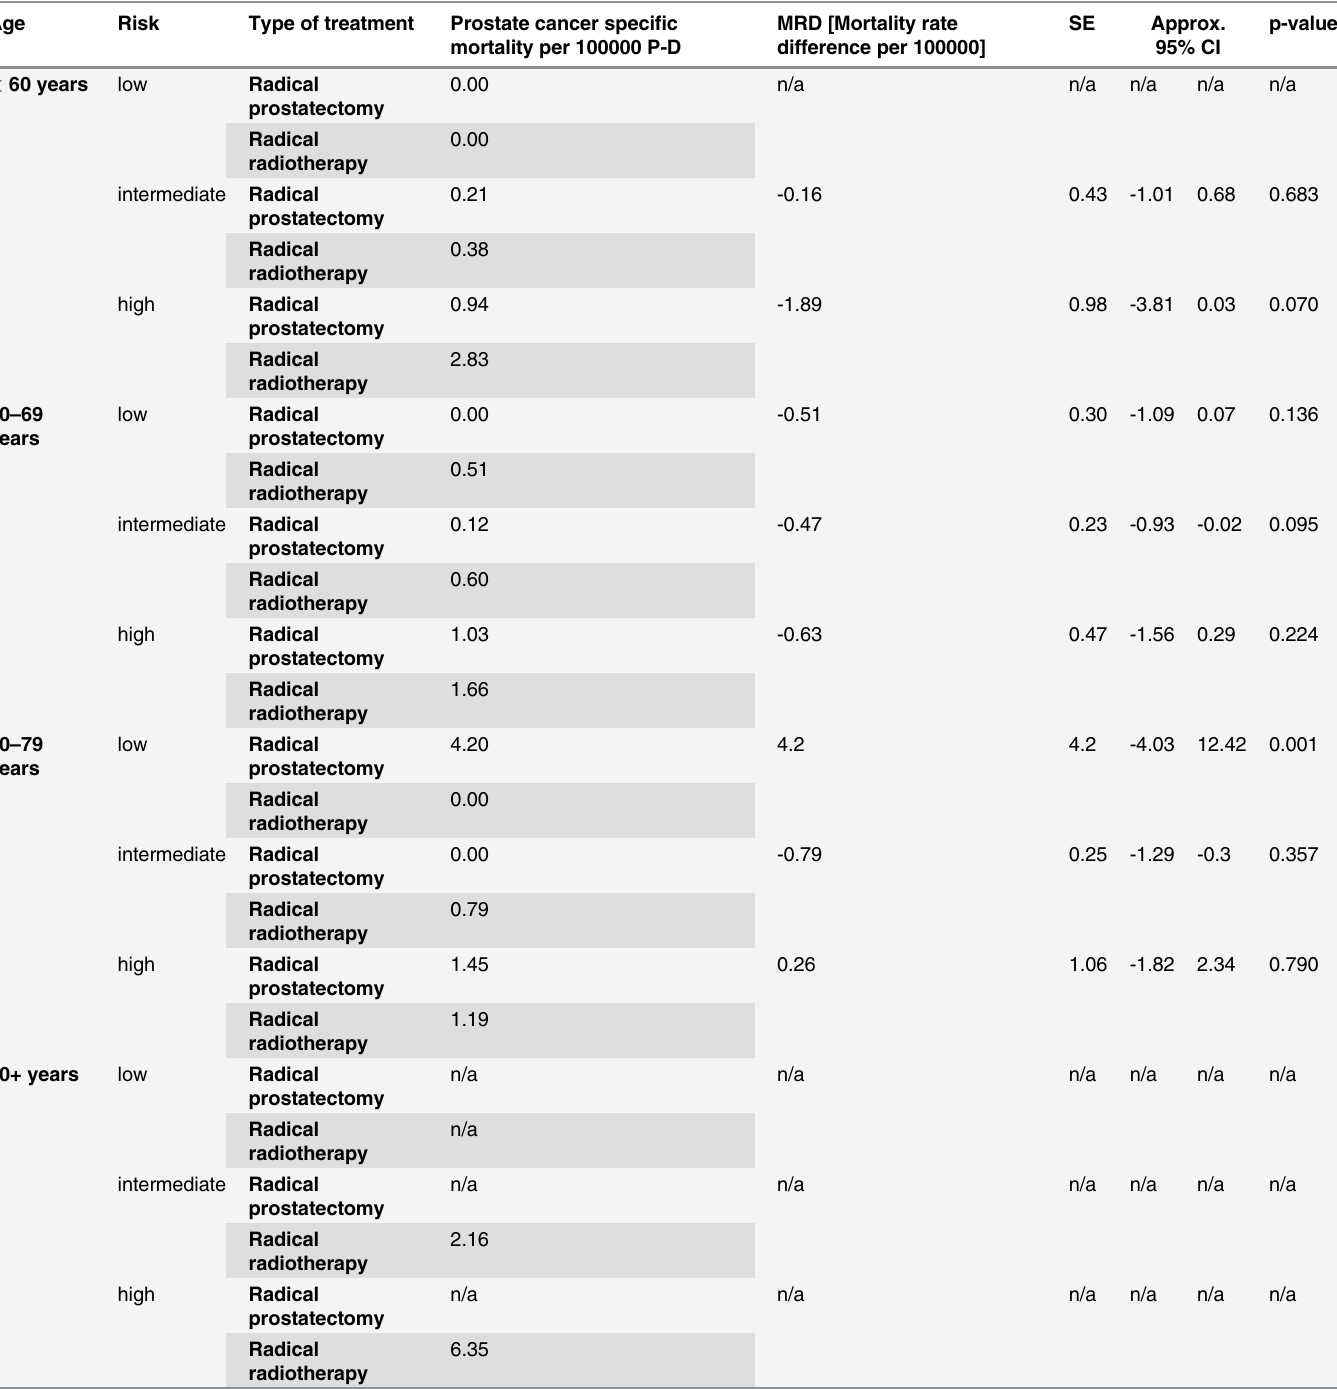
Table 5. Comparative cancer speci fi c mortality between radical prostatectomy and radical radiotherapy in groups strati fi ed by age and risk